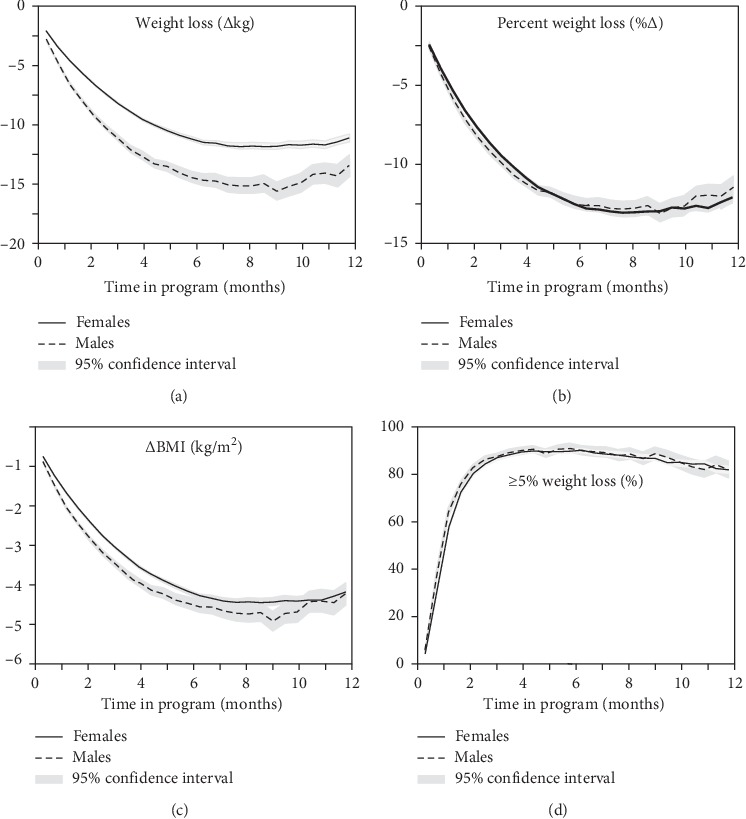
Changes in weight (∆kg), percent change in weight, BMI (∆kg/m2), and percent of patients with ≥5% weight loss in JumpstartMD patients over time. Shaded areas designate 95% confidence interval. Sample sizes were 18,769 women and 3686 for all variables except BMI, which were 18115 women and 3528 men due to missing heights.